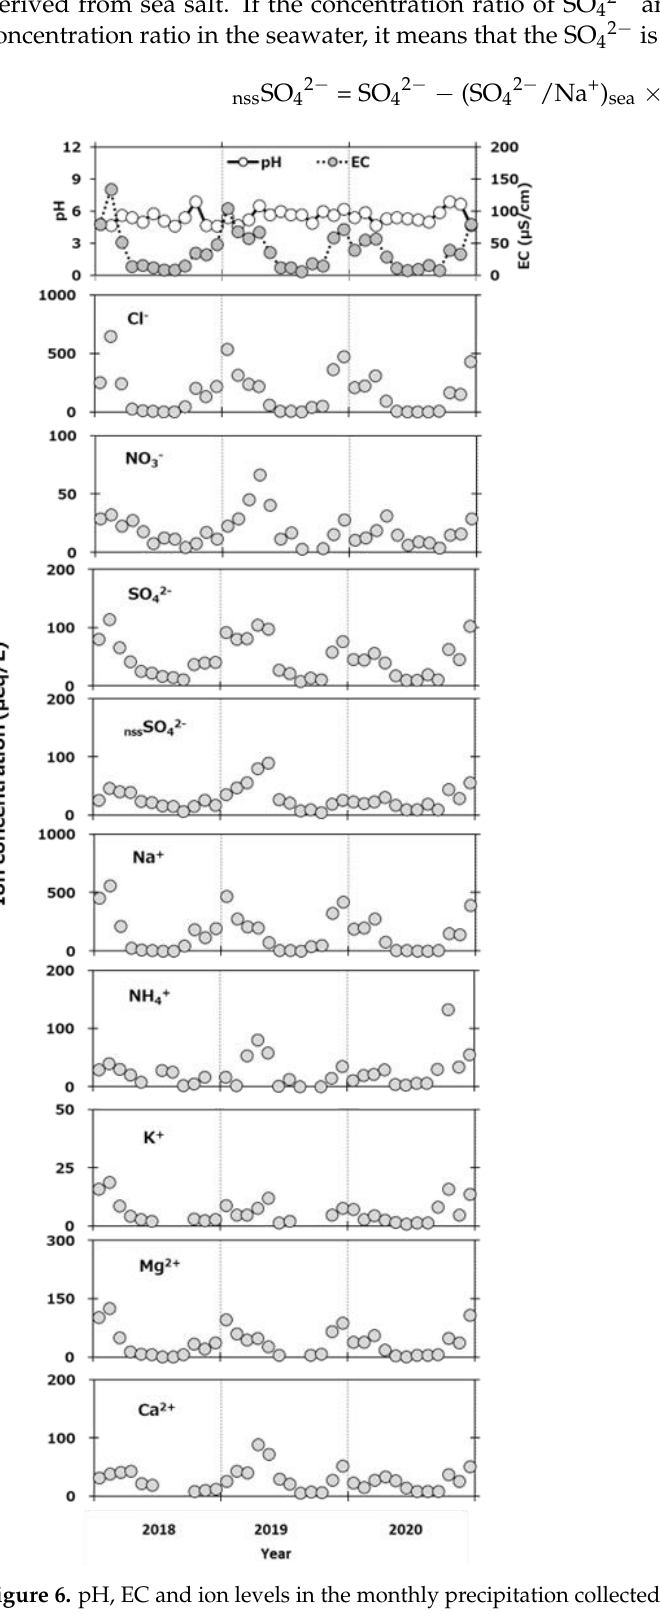
Figure 6. pH, EC and ion levels in the monthly precipitation collected in Hirosaki City (2018 to 2020).